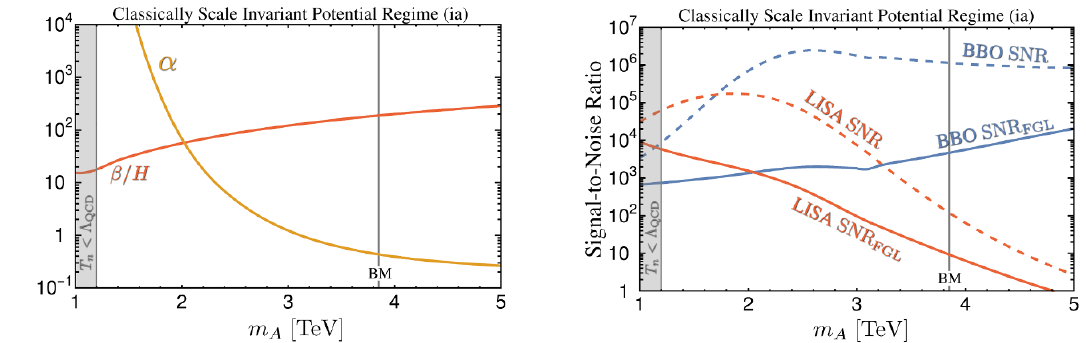
Figure 7 . Left: the key phase transition parameters in regime (ia) of the scale invariant case. Right: the SNR for LISA and BBO. The Bodeker-Moore criterion, showing v w ’ 1, is satis(cid:12)ed for m A . 3 : 8 TeV. Above this we still assume v w (cid:25) 1, though it could be lower, which would reduce the SNR.